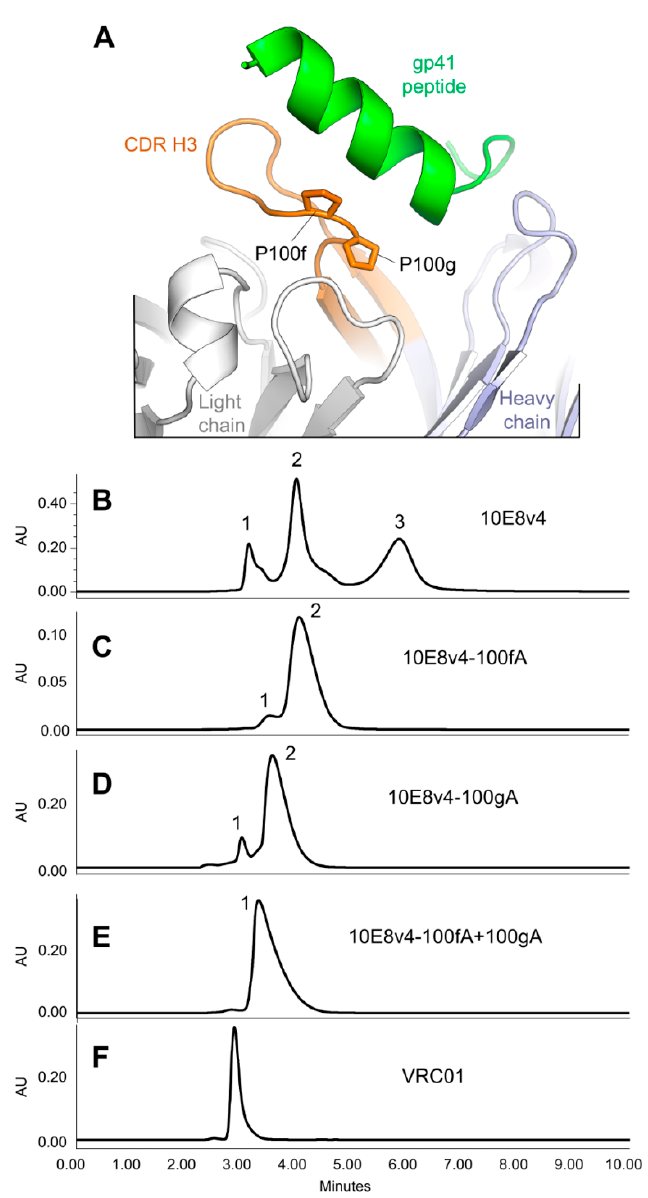
Figure 4. Modifications of a di-proline motif in the CDR H3 alter the SEC profile. ( A ) Prolines at residues 100f and 100g are highlighted in stick representation (Kabat residue numbering is used for antibody). ( B ) The SEC profile of 10E8v4. ( C ) The SEC profile of 10E8v4-P100fa. ( D ) The SEC profile of 10E8v4-P100gA. ( E ) The SEC profile of 10E8v4-P100fA+P100gA. ( F ) The SEC profile of VRC01.